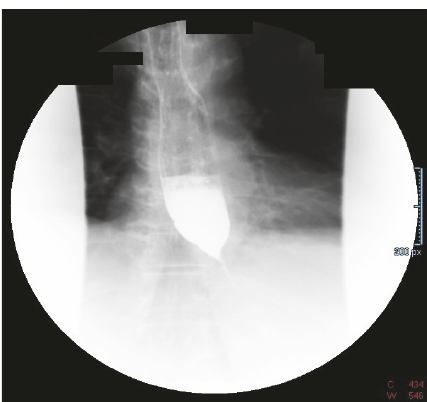
Figure 2: CT scan (coronal view) showing a 12 x 12 soft tissue mass in the gastrohepatic omentum (blue arrows) compressing the distal esophagus (yellow arrow) and gastric fundus.